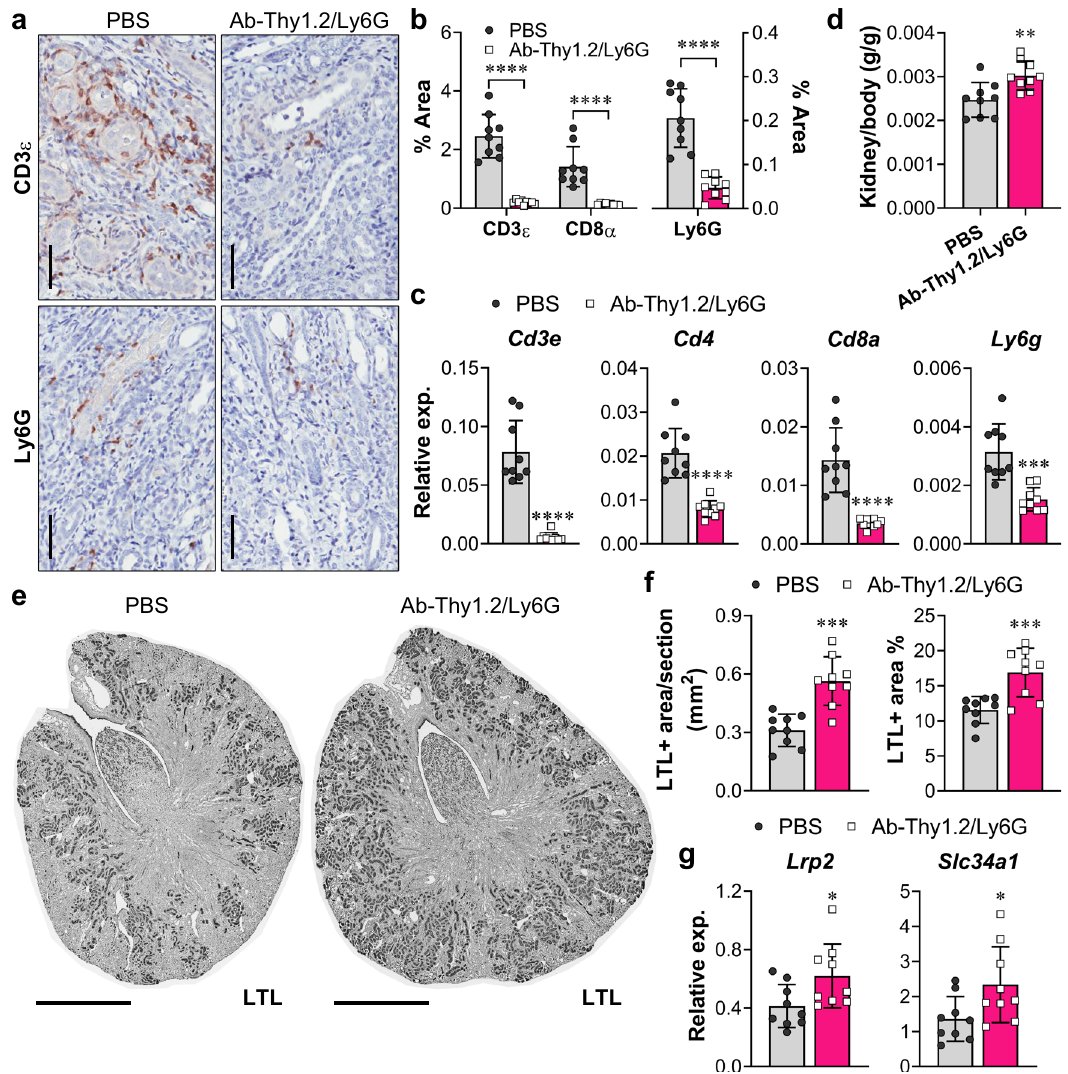
Fig. 9 | Dual depletion of T cells and neutrophils attenuates kidney tubule atrophy. WT mice were treated as described in Methods with either PBS or a combination of antibodies (Ab)-against Thy1.2 and Ly6G beginning 5 days after unilateral ischemia/reperfusion injury (U-IRI) and sacri fi ced on day 30. a The IRI kidney sections were immunostained with CD3 ε and Ly6G. Nine kidneys/group were sectioned and stained, and representative images are shown. Scale bars, 25 µ m. b CD3 ε -,CD8 α -,andLy6G-positiveareaswerequanti fi edusingImageJ.Data are presented as mean±SD. n =9 kidney sections/group. **** p <0.0001 by unpaired two-tailed t -test. c Quantitative RT-PCR analysis for Cd3e , Cd4 , Cd8a , and Ly6g was performed on whole-kidney RNA on day 30 after U-IRI±dual T-cell/neu- trophil depletion. Data are presented as mean±SD. n =9 kidneys/group. *** p <0.001, **** p <0.0001 by unpaired two-tailed t -test. d Kidney-to-body